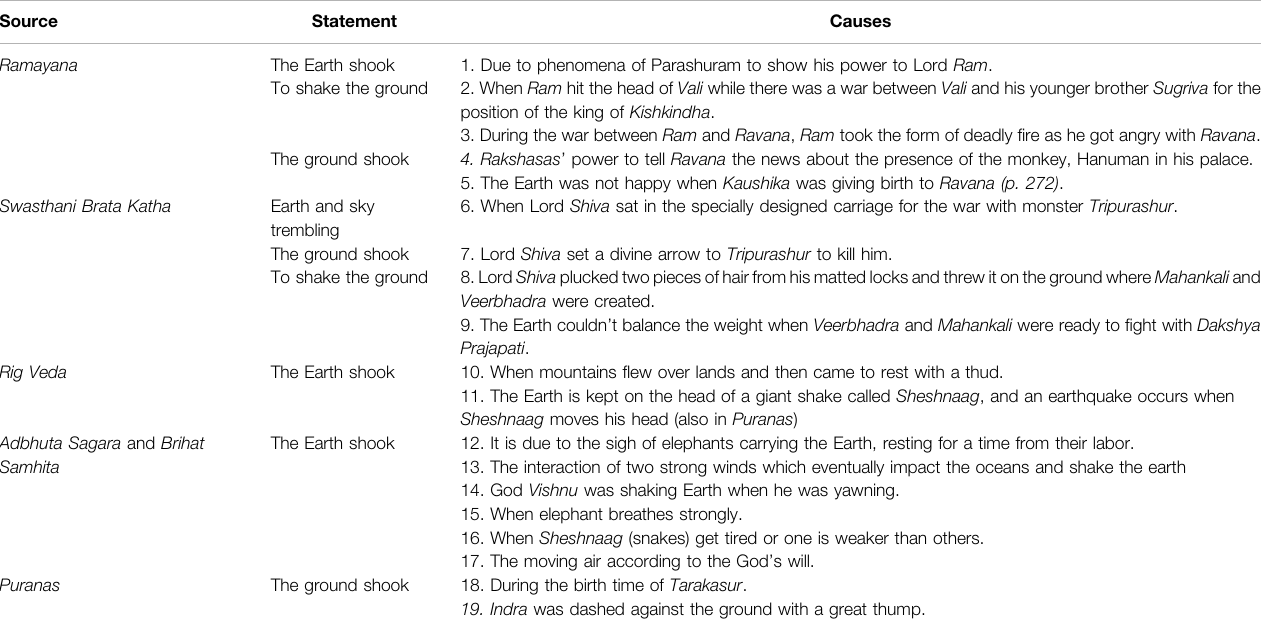
TABLE 1 | Summary of earthquake mentions in different phrases found in the researched